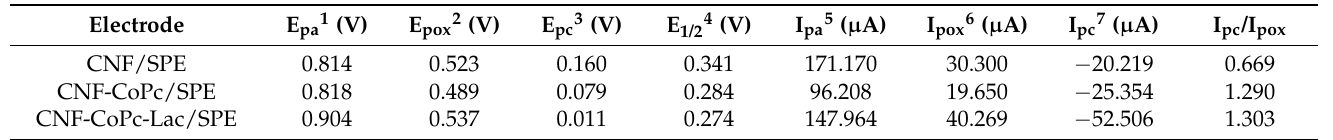
Table 1. The values of the parameters obtained from the cyclic voltammograms of all the electrodes immersed in 10 − 3 M p-coumaric acid solution (the electrolyte support was 0.1 M PBS of pH 5.0). Electrode